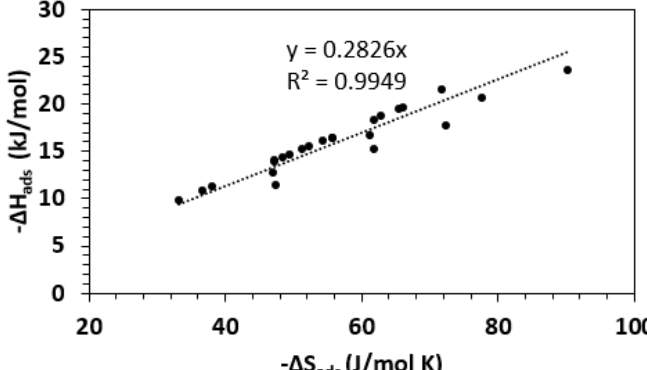
Figure 7. Relationship between ∆ H ads and ∆ S ads of methane for various MOFs from experiments. Each point represents a MOF whose enthalpy and entropy of adsorption was determined from experimental data at 1 bar.